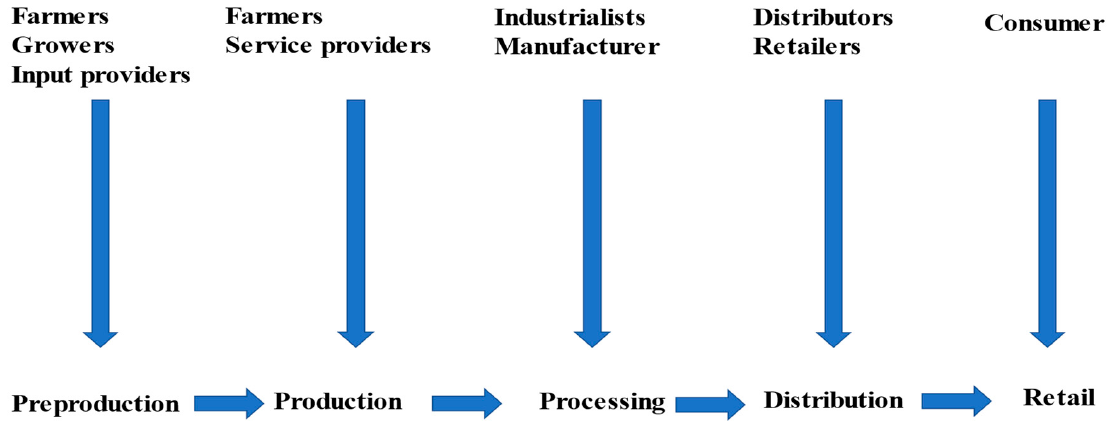
Figure 2. Stakeholders at each stage of conventional FSC.